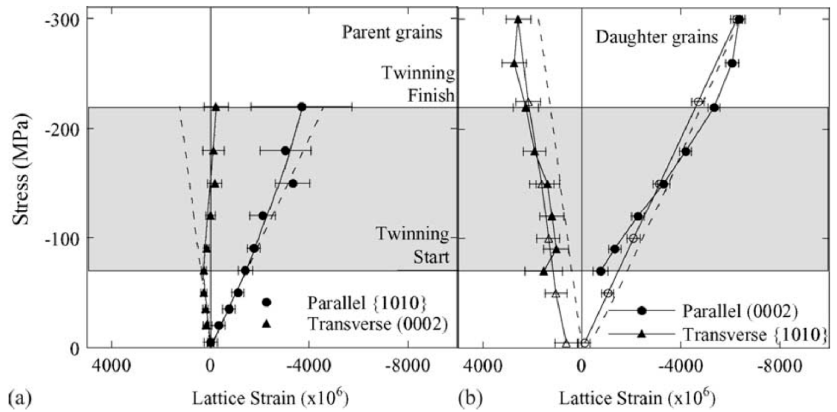
Figure 36. The variation of lattice strain parallel and perpendicular to the loading axis versus the applied load: ( a ) Untwinned Parent grains, ( b ) daughter twinned grains (After Brown et al. [34]). The dashed line represents the theoretical linear elastic relation. Closed markers denote the loading path, while the open markers represent the unloading path.